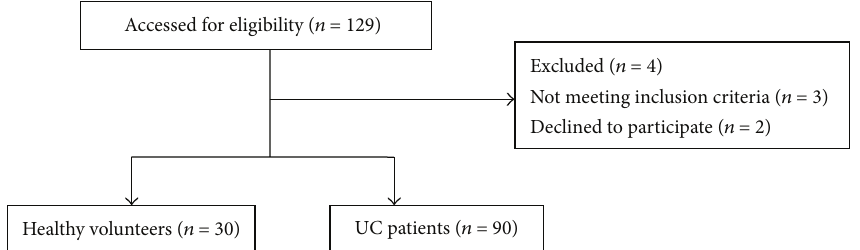
Figure 1: Study flow through